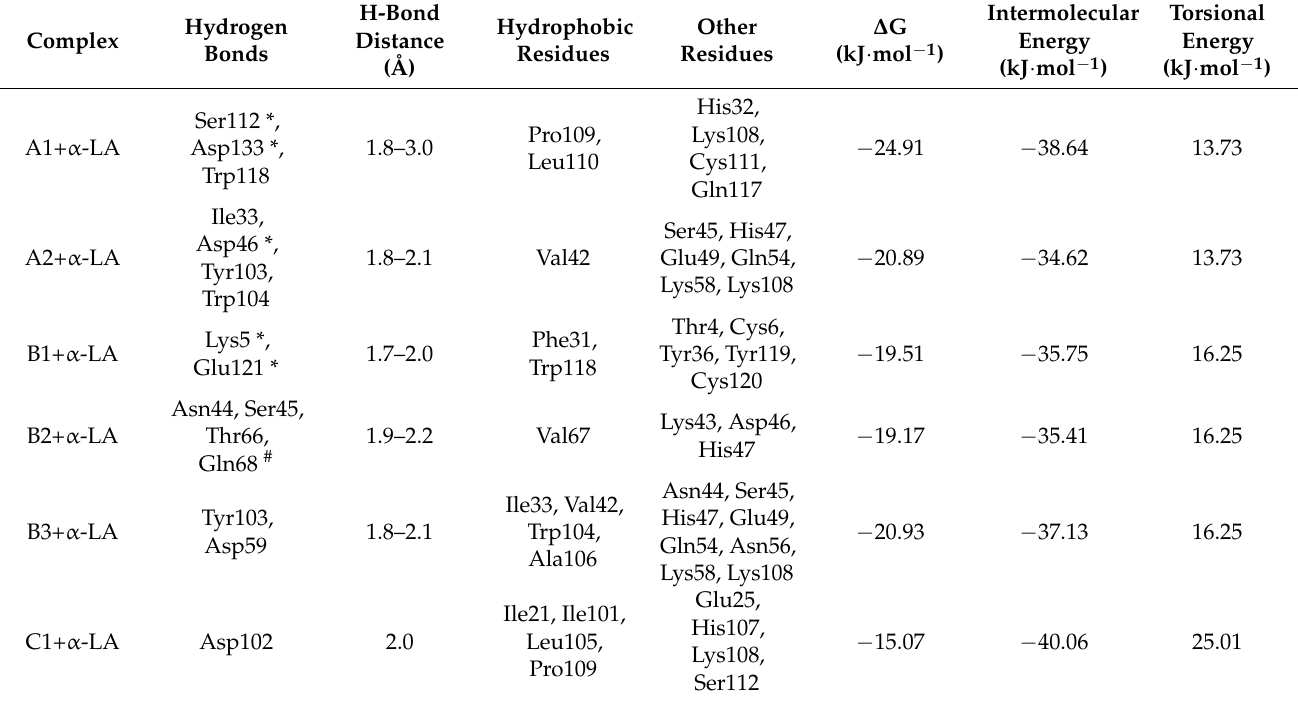
Table 6. Molecular docking parameters for proanthocyanidins binding to α